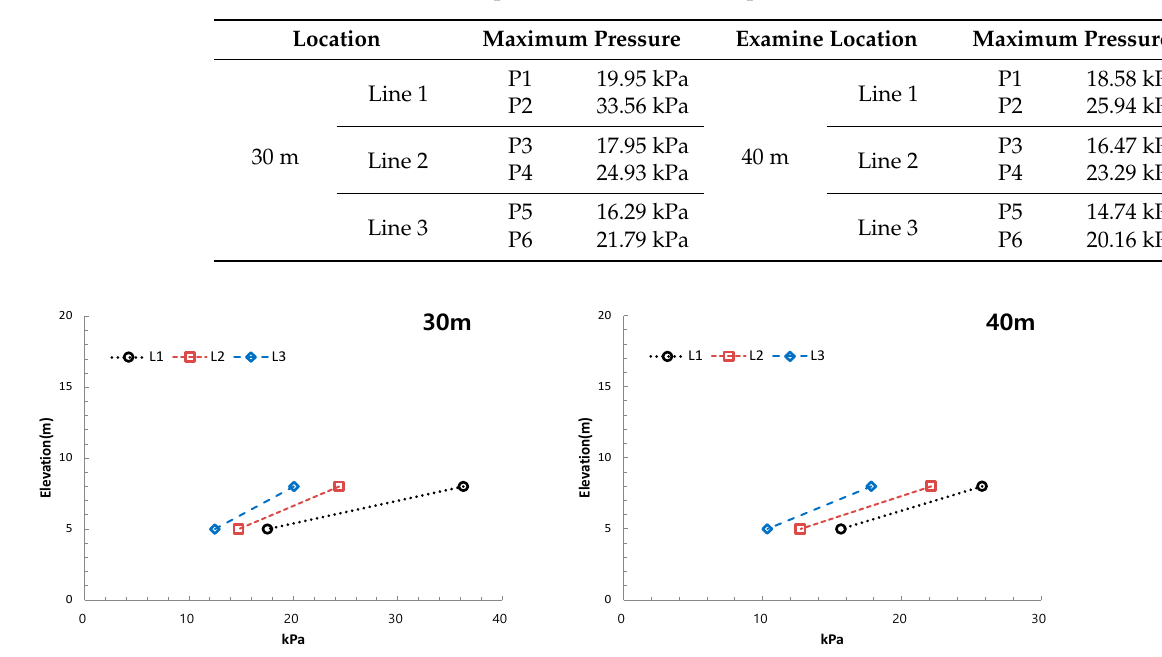
Table 7. Details of the wave pressure measurement experiment.